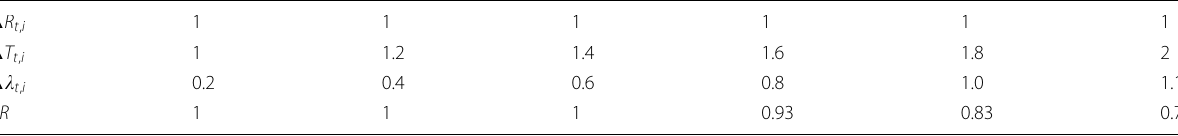
Table 4 Recall Rate with different